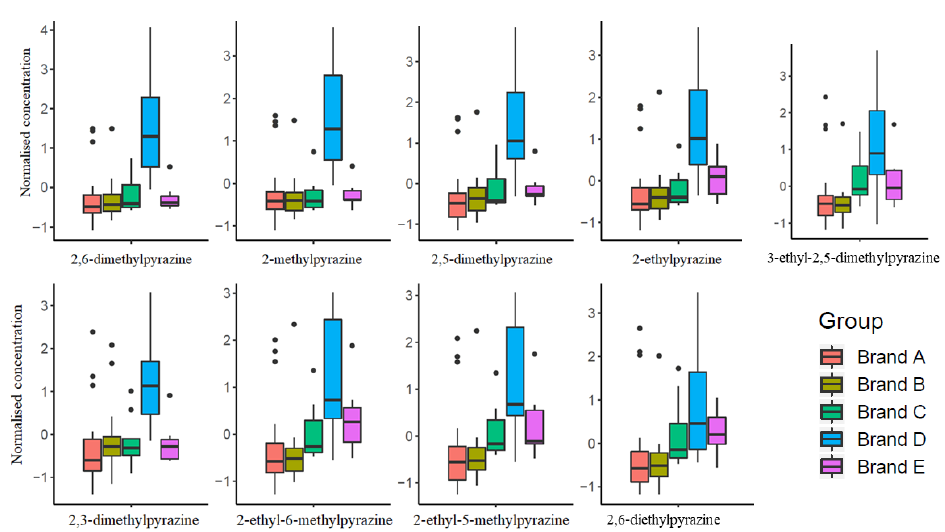
Figure 4. Selected pyrazines by PLS-DA detected in ECs.